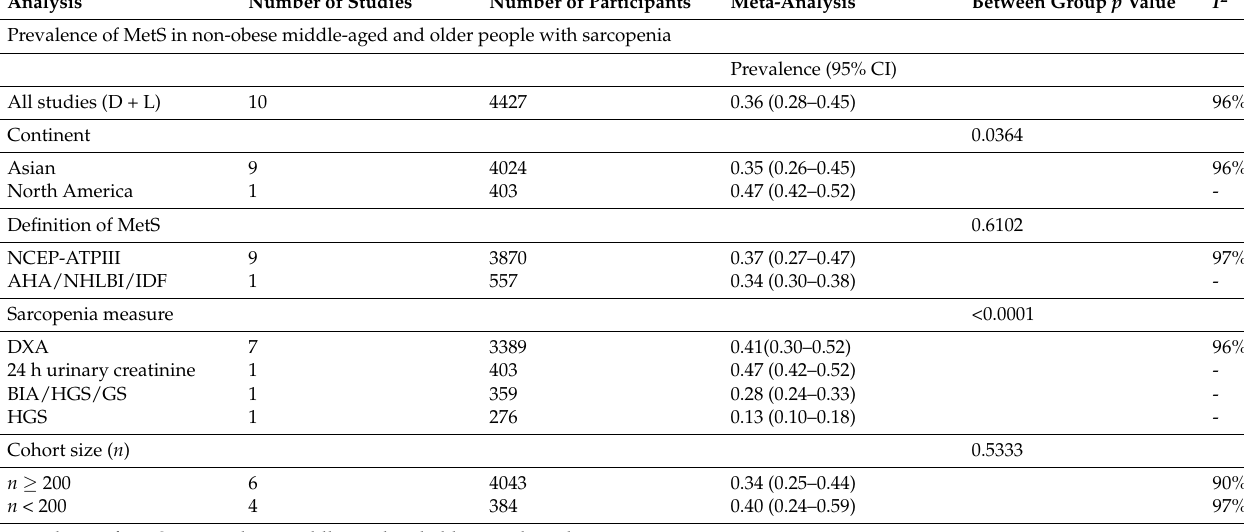
Table 2. Meta-analysis results of prevalence of metabolic syndrome in middle-aged and older non-obese adults with or without sarcopenia.